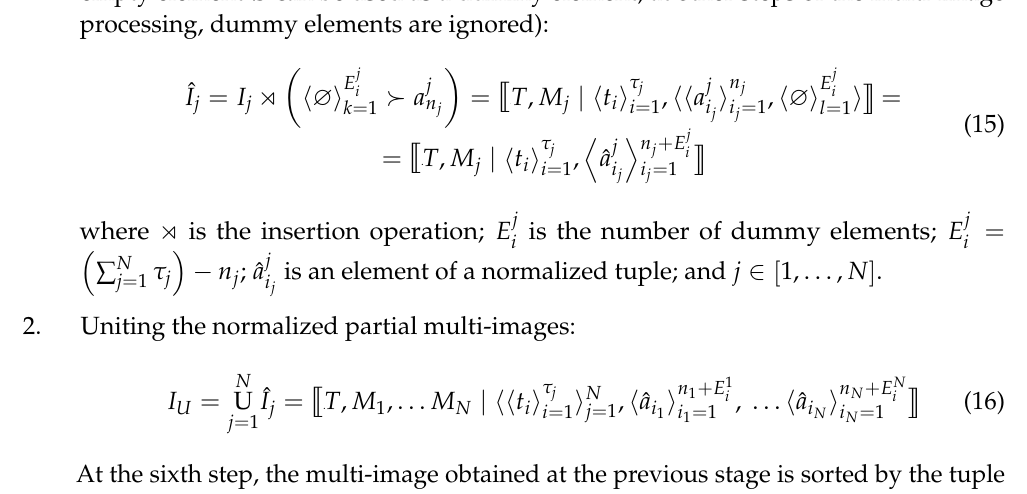
Figure 3. An example of two incompatible aggregates.